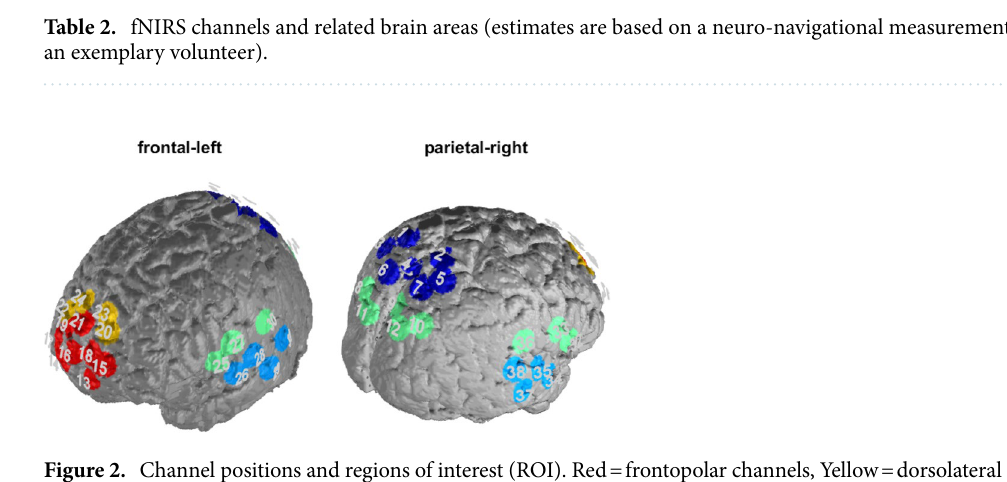
algorithm 69 , visual inspection and single channel interpolation in case of artefacts and a global signal reduction with a spatial gaussian kernel filter 70 with a standard deviation of σ = 38. After preprocessing, the amplitude of low frequency fluctuations was computed 44 . We chose not to assess the average hemodynamic response during the 3 min rumination induction due to the implemented filters. The application of a high-pass filter at 0.01 Hz is critical for the removal of low frequency drifts of the signal. However, such a filter also ensures an activity near zero over the course of 3 min as the filter reduces the low-frequency activity in the time window (one oscillation in 3 min would imply an effect in a frequency lower than 0.005 Hz). A solution for the assessment of activity during the 3 min offers the assessment of the amplitude of low frequency fluctuations. We assessed the power of the frequency spectrum of 0.01 to 0.1 Hz by the pwelch function of MATLAB (Welch’s power spectral density estimate) with 30 s time windows. Afterwards, we computed the average amplitude of the fluctuations as the mean of the square root of the power spectrum for each frequency bin. The resulting metric offers the average amplitude within the frequency range without addressing positive or negative values that would result in a near zero hemodynamic response when computing the simple average of the signal. Note that we did not standardize ALFF values as unlike in fMRI data, fNIRS data provided non-arbitrary values. However, recent developments in amplitude fluctuation research suggest various parameters and algorithms to assess signal fluctuations. A re- cent publication suggests that the Percent Amplitude of Fluctuation (PerAF) might be a more robust parameter, as it accounts for the arbitrary units of fMRI data 71 . To compare the ALFF data, we additionally calculated and analyzed the PerAF. Figures were created using ggplot2 in R and brain maps using self-written code in MATLAB 2017a. With